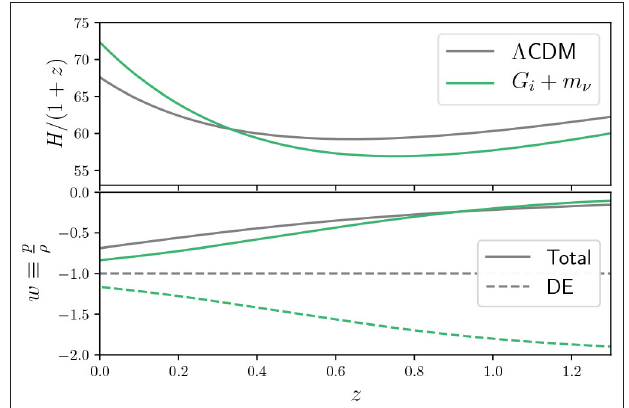
FIGURE 9 | Hubble parameter H and equation of state (EoS) w as a function of redshift for the SM of Cosmology ( 3 CDM) and for covariant Galileons with massive neutrinos. In the bottom panel, the total EoS w tot compared with the EoS of DE w DE